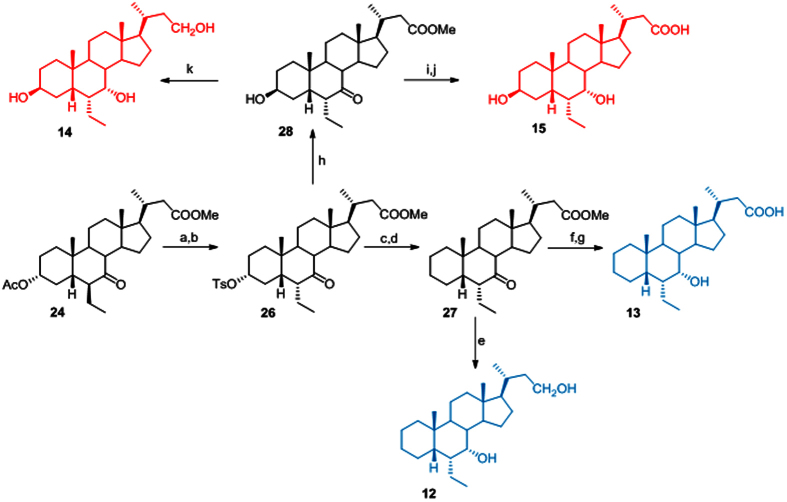
Synthesis of 3-deoxy- and 3β-hydroxy-6α-ethylnorcholane derivatives.Reagents and conditions: (a) MeONa, MeOH; (b) p-TsCl, pyridine, 73% over two steps; (c) LiBr, Li2CO3, DMF, reflux, (d) H2, Pd(OH)2, THF/MeOH 1:1, room temperature, quantitative yield over two steps; (e) LiBH4, MeOH dry, THF, 0 °C, 70%; (f) NaOH, MeOH:H2O 1:1 v/v; (g) LiBH4, MeOH dry, THF, 0 °C, 92% over two steps; (h) CH3COOK, DMF:H2O 5:1 v/v; (i) NaOH, MeOH:H2O 1:1 v/v; (j) LiBH4, MeOH dry, THF, 0 °C, 58% over two steps; (k) LiBH4, MeOH dry, THF, 0 °C, 57%.